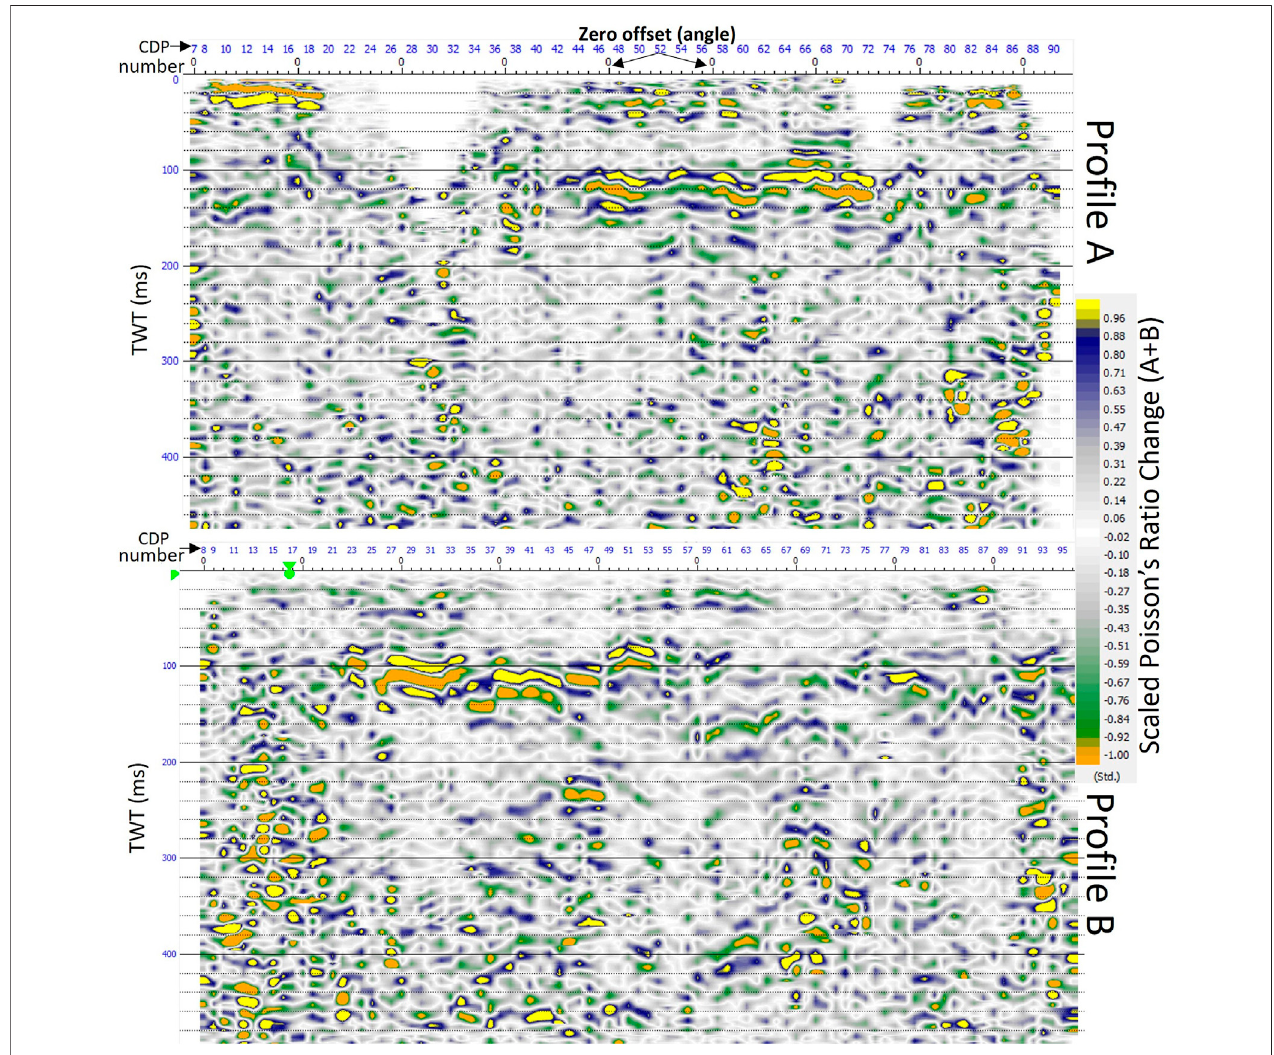
FIGURE 8 | Scaled Poisson ratio changes for both pro fi les (A) and (B) as a direct gas indicator shows the gas-saturated zones in orange color.